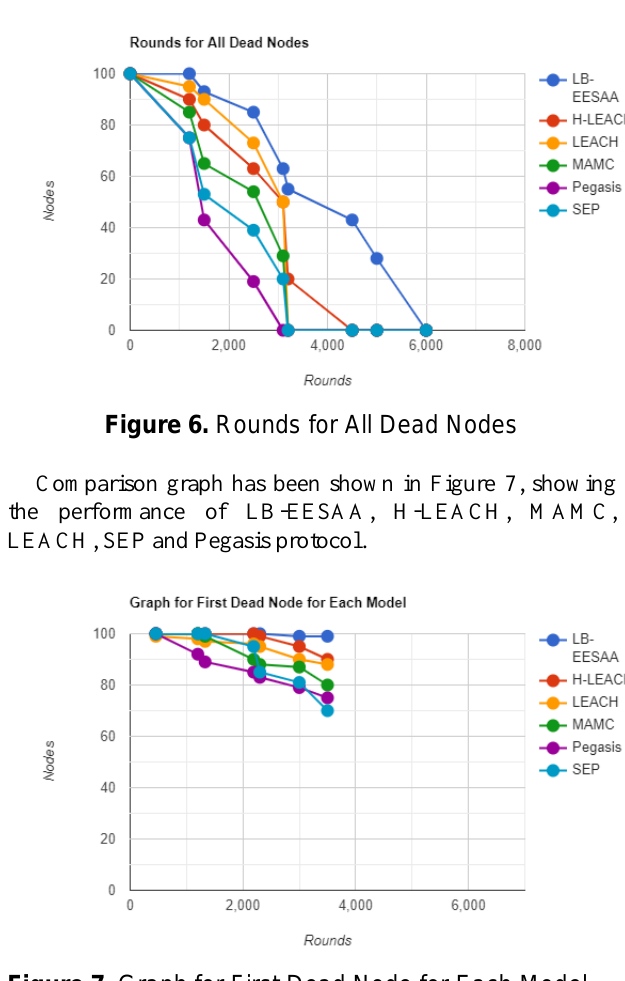
Figure 7. Graph for First Dead Node for Each Model